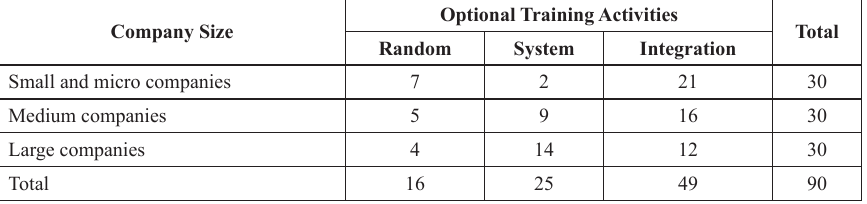
Table 2. Character of optional on-the-job training according to the employer’s approach Company Size